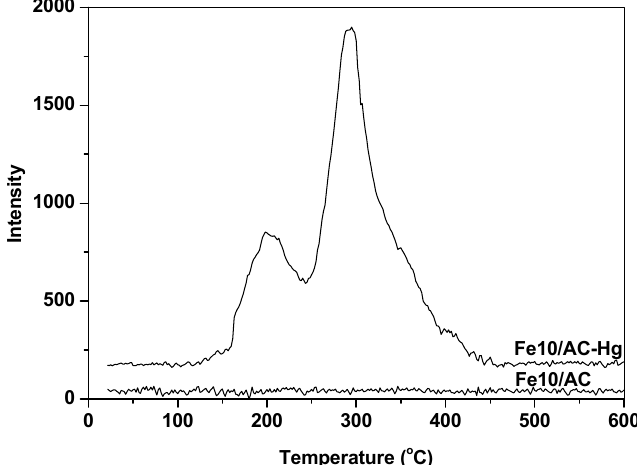
Figure 4. Hg release of the fresh and spent Fe10/AC samples during the TPD process.